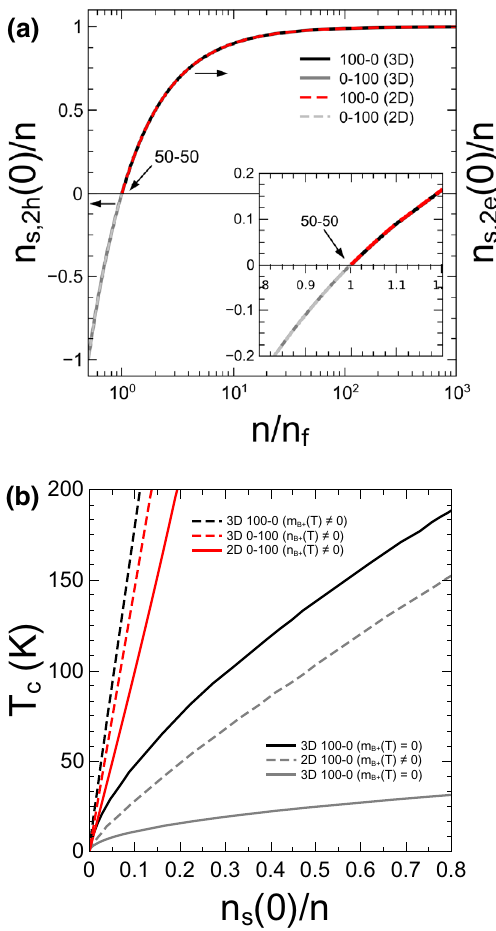
Fig. 1 (Color online) a Dimensionless superfluid density n s ( 0 )∕ n vs. n ∕ n f for 100%–0% (black full) curve, 0%–100% (gray-dashed) curve using (17) and (18), respectively, for 3D and 100%–0% (red dashed) curve, 0%–100% (gray dashed) curve using the same equations for 2D. When n ∕ n f ≃ 10 3 one have n s ,2 e ( 0 )∕ n ≃ 1 and when n ∕ n f ≃ 0.5 one has n s ,2 h ( 0 )∕ n ≃ − 1 . One has the negative sign in the superfluid density of 0%–100% case, this is consistent with 2hCPs charge car- riers sign in (4). Inset shows the behavior of superluid density near n ∕ n 1 (weak coupling) extreme. Also there is a sign symmetry f = with respect this point between 100%–0% and 0%–100% cases. b Critical temperature T c vs n s ( 0 )∕ n from the extended crossover the- ory for the 100%–0% and 0%–100% cases in 3D and 2D, m B + ( T ) = 0 indicate that excited 2hCPs have been ignored and n B + ( T ) = 0 that excited 2eCPs have also been ignored. Note that the mere pres- ence of 2hCPs enhance critical temperatures. One can see a linear behavior still holds at relatively high superfluid densities, this lin- ear behavior holds in the strong-coupling regime as Božović et al. [34] found in their Fig. 2d. Here ̃ G = 10 − 4 and 𝛿 ̃𝜖 = 10 − 3 were used; “tilde” meaning made dimensionless with the Fermi energy E